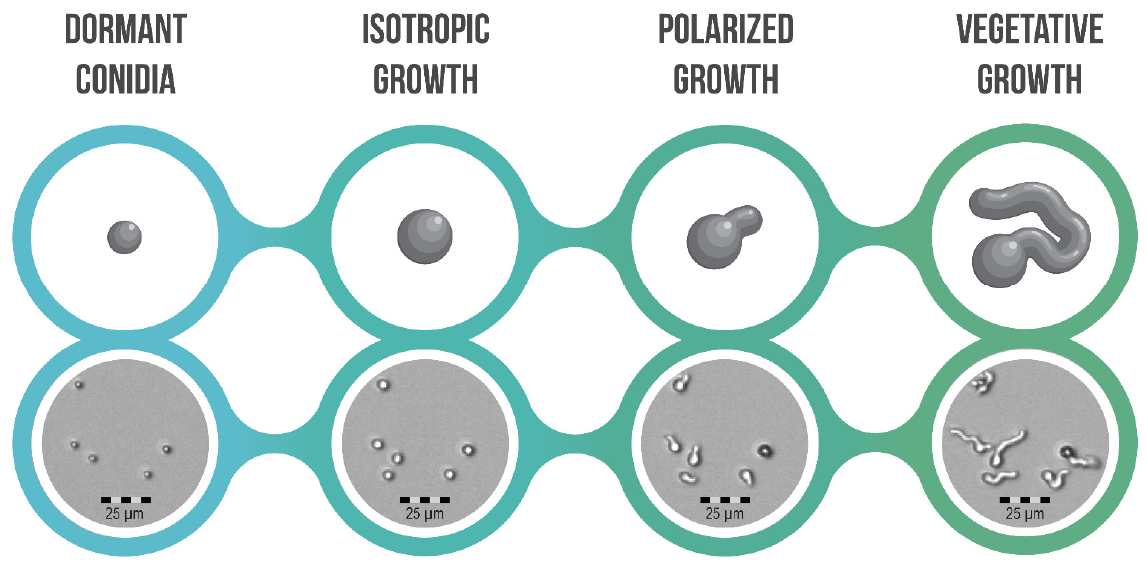
Figure 2. Morphotypes of conidial germination in Aspergilli. Graphical representation ( top ) and Fluidscope TM images of A. fumigatus conidia taken through time with oCelloScope ( bottom ) (Biosense Solutions, www.biosensesolutions.dk, accessed on 21 July 2022 [172]). Transitions and Differences between Morphotypes; How Are They